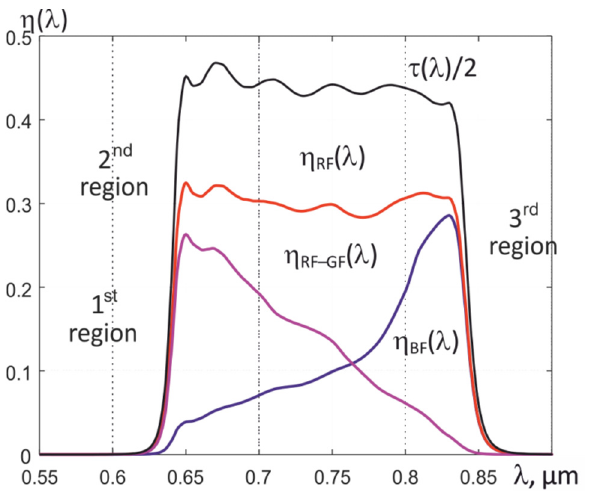
Figure 6. Spectral quantum efficiencies of RGB elements of the matrix of silicon photodetectors